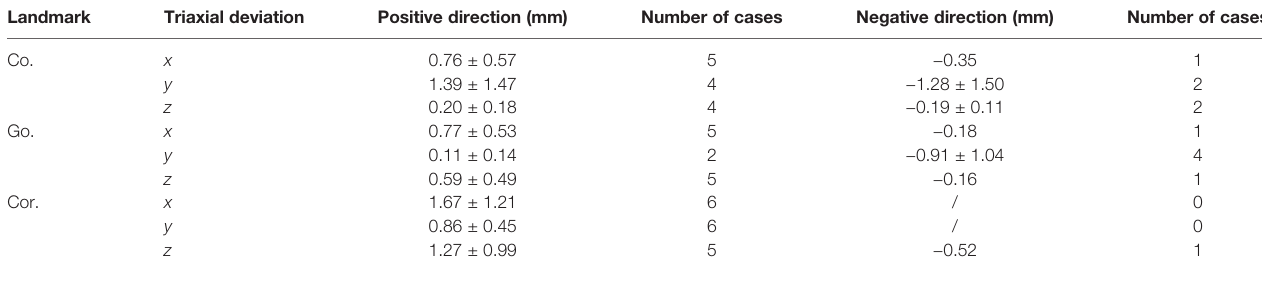
TABLE 4 | Triaxial deviation of mandibular anatomical landmarks in CORPPP-guided patients without ramus reconstruction. Landmark